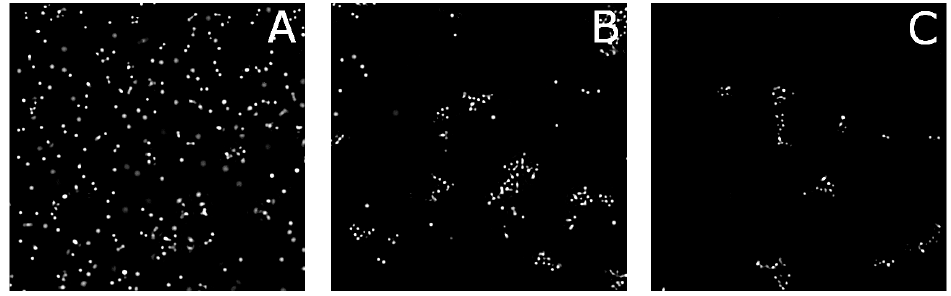
Figure 4. Optical microscopy images for different chain lengths at 32 ◦ C in 10 mM NaCl for a grafting density of 3.0%. ( A ) DP = 10; ( B ) DP = 30; and ( C ) DP =